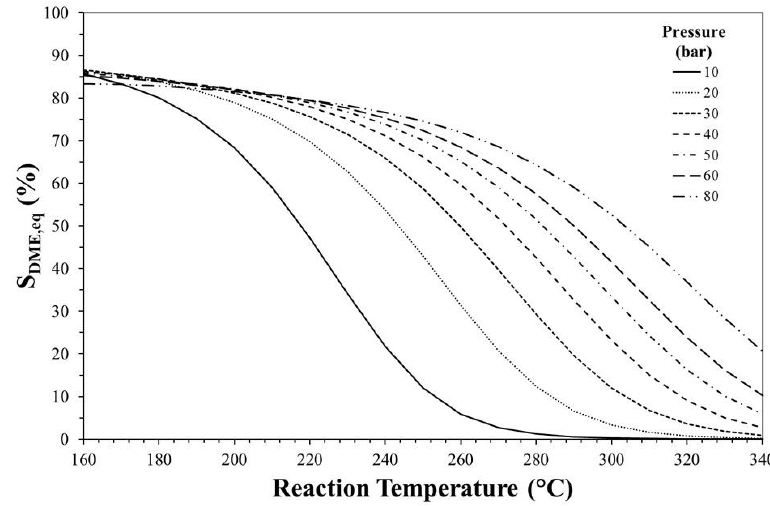
Figure 3. Effect of reaction temperature and pressure on DME equilibrium selectivity. Initial H 2 /CO 2 molar ratio equals to 3.